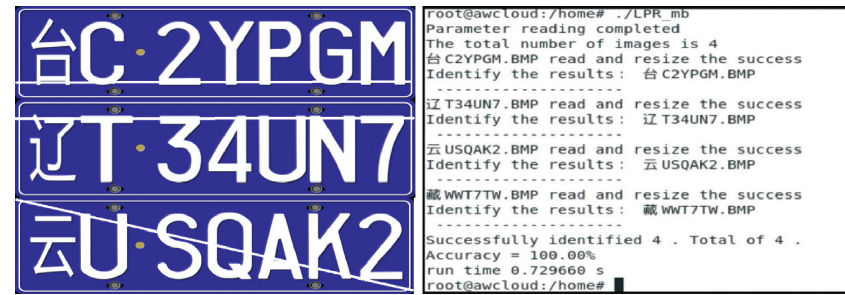
Figure 11: Interference and recognition results of three different parts.